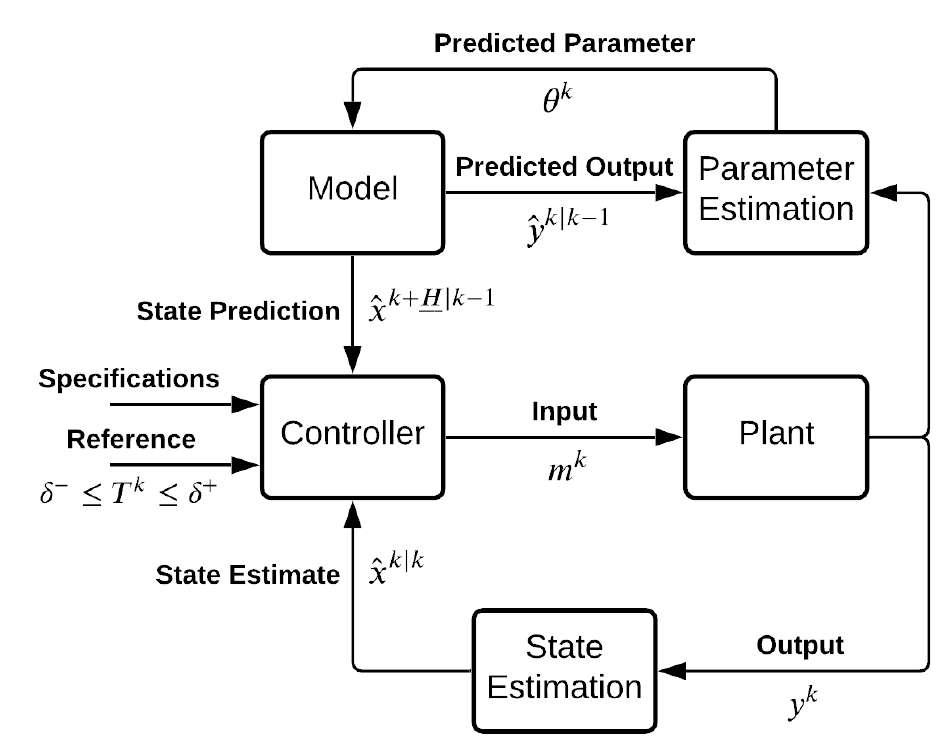
Figure 5. MPC architecture with parameter